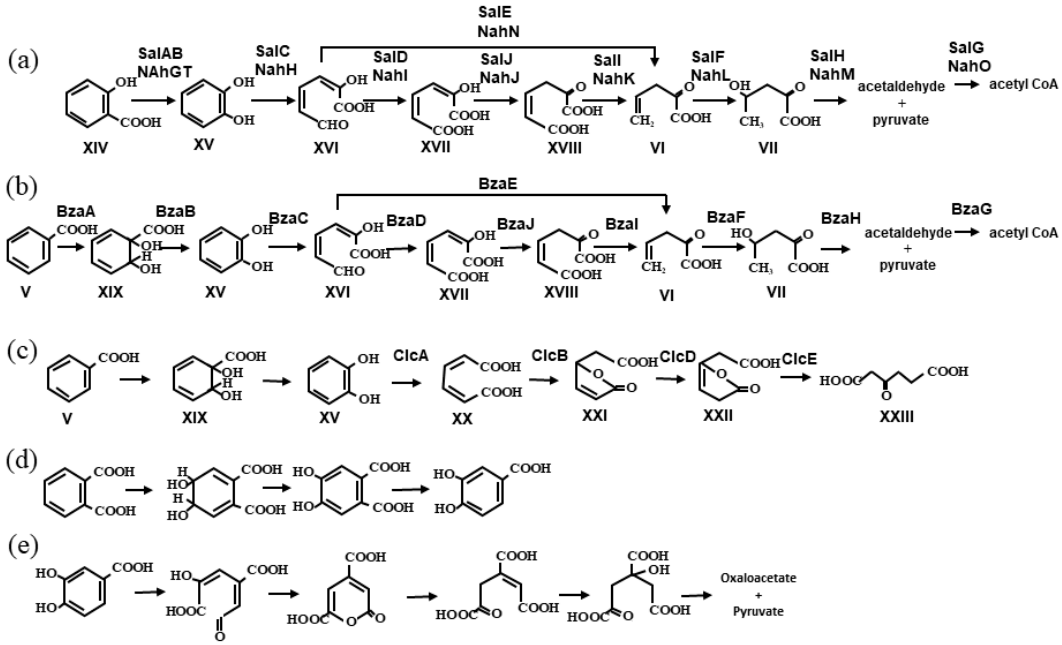
Figure 2. Aerobic degradation pathways for aromatic carboxylic acids ( a ) salicyliate ( b ) benzoate ( meta -pathway), ( c ) benzoate ( ortho -pathway), ( d ) phthalate and ( e ) protocatechuate encoded on degradative ICEs. The names of the intermediate compounds are as follows: salicylic acid (XIV), cate- chol (XV), 2-hydroxy- cis,cis -muconate semialdehyde (XVI), 2-hydroxy-hexa-2,4-diene-1,6-dioic acid (XVII), 2-oxohex-4-ene-1,6-dioic acid (4-oxalocrotonate) (XVIII), cis -1,6-dihydroxy-2,4-cyclohexadiene- 1-carboxylic acid (XIX), cis,cis -muconate (XX), muconolactone (XXI), 3-oxoadipate enol-lactone (XXII), and 3-oxoadipic acid (XXIII). The compound names of (V), (VI), and (VII) are same as those in Figure 1. The Enzyme names on each arrow are: SalAB/NahGT, salicylate hydroxylase; BzaA, benzoate 1,2-dioxygenase; BzaB, 2-hydro-1,2-dihydroxybenzoate dehydrogenase (benzoate cis -diol dehydrogenase); SalC/NahH/BzaC, catechol 2,3-dioxygenase; SalD/NahI/BzaD, hydroxymuconic semialdehyde dehydrogenase; SalE/NahN/BzaE, 2-hydroxymuconate semialdehyde hydrolase; SalJ/NahJ/BzaJ, 4-oxalocrotonate isomerase; SalI/NahK/BzaI, 4-oxalocrotonate decarboxylase; SalF/ NahL,/BzaF, 2-oxopent-4-enoate hydratase; SalH/NahM/ BzaH, 2-oxo-4-hydroxypentanoate al- dolase; SalG/NahO/BzaG, acetaldehyde dehydrogenase; ClcA, catechol 1,2-dioxygenase; ClcB, muconate cycloisomerase; ClcD, muconolactone D-isomerase; and ClcE, 3-oxoadipate enol-lactonase. The intermediate compounds names and enzyme names in ( d , e ) are described in reference